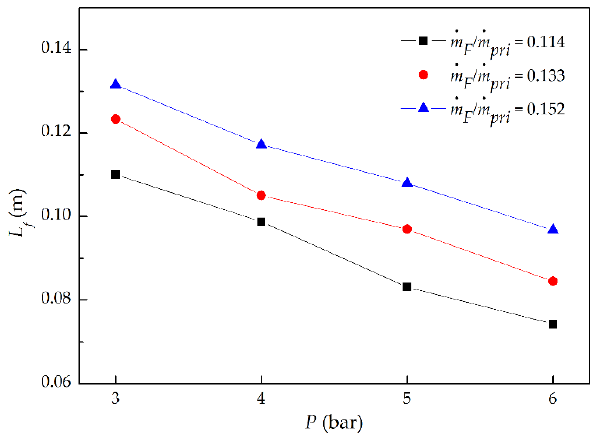
Figure 7. Flame length for combustor pressure under different ṁ F / ṁ pri ratios.